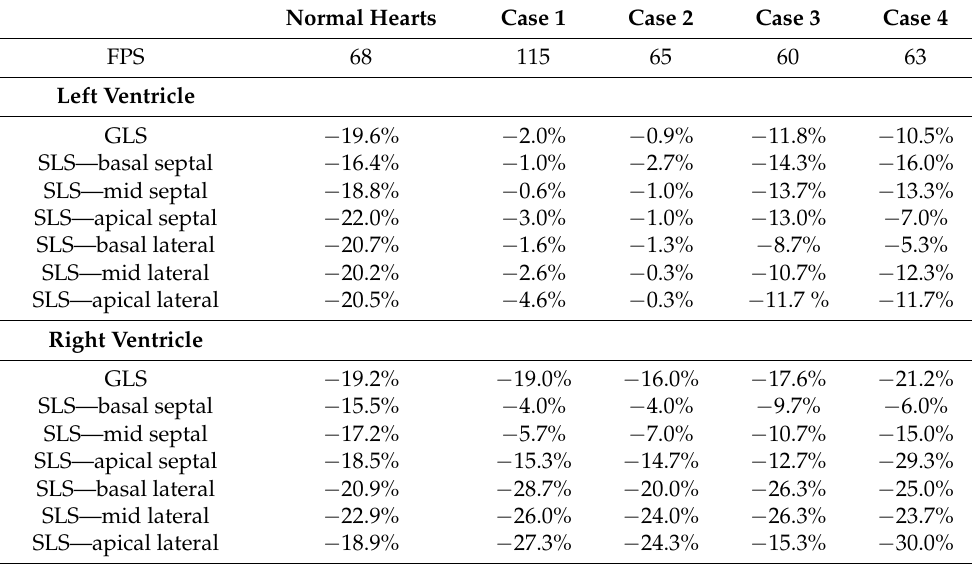
Table 3. Decreased myocardial deformation in aortic stenosis cases. Normal Hearts Case 1 Case 2 Case 3 Case